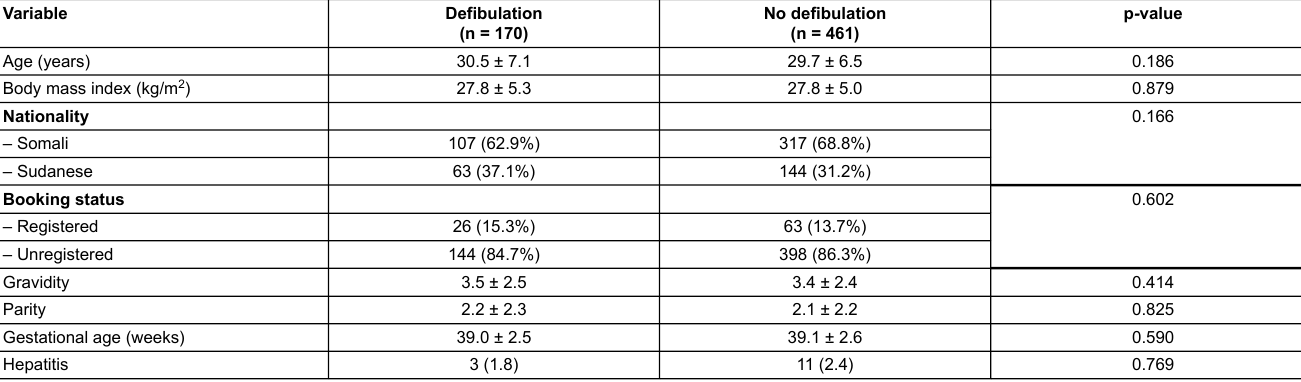
Table 1: Description and comparison of the demographic characteristics and medical history of the defibulated patients and the control group. Variable